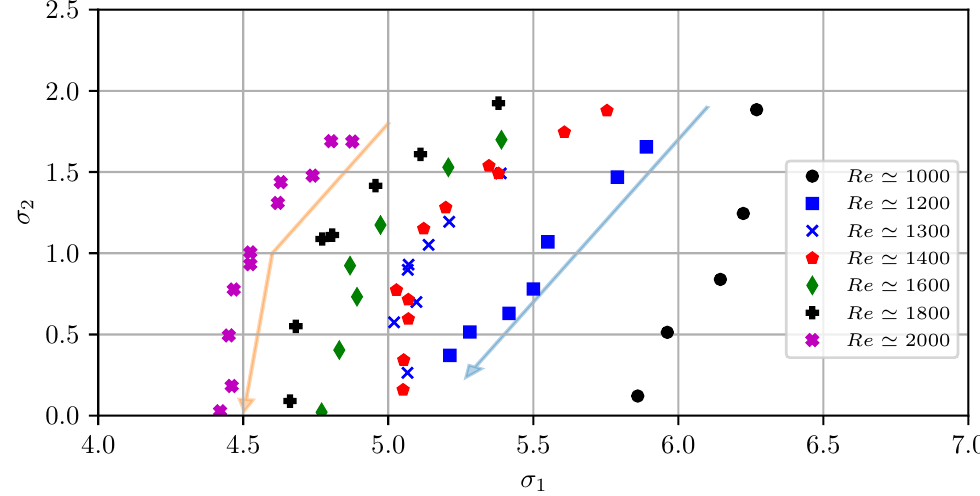
σ 2 ). The different −